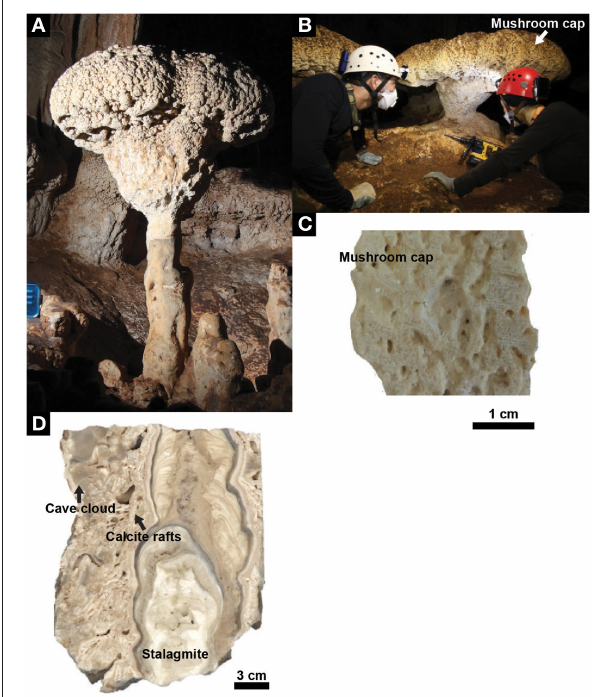
FIGURE 1 | Mushroom speleothem. (A) A representative mushroom in Santa Catalina Cave, Cuba . (B) Mushroom speleothem from where the core samples used for laboratory analyses were drilled. (C) Cross section showing the internal structure of the mushroom cap. (D) Cross section showing the internal structure of the different units that, together with the mushroom cap, constitute the speleothem (i.e., stalagmite, calcite rafts, cave cloud).